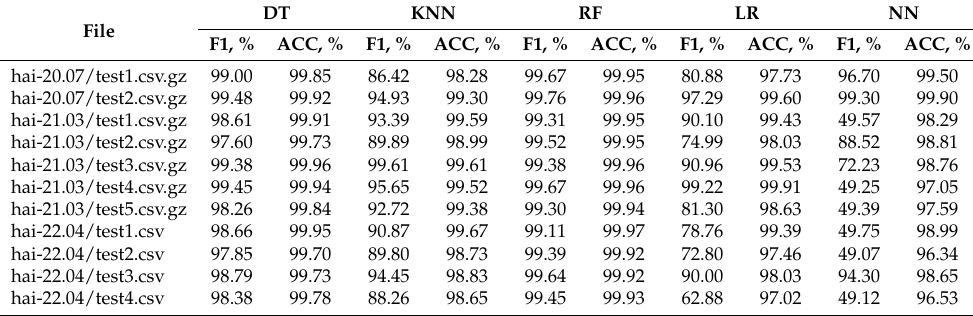
Table 10. Result of evaluating classifiers on HAI